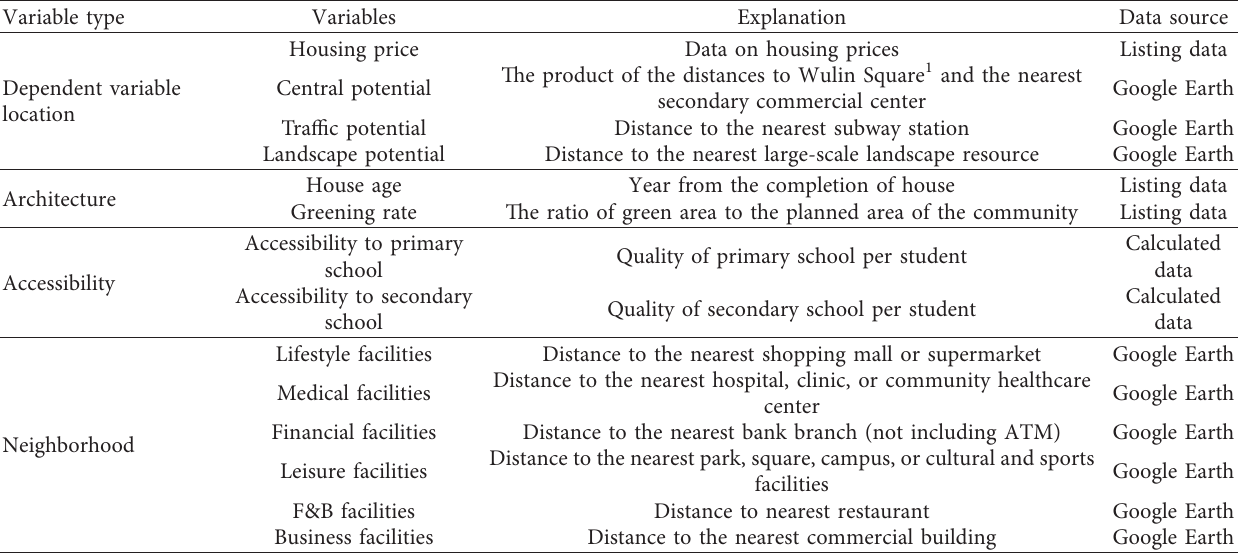
Table 1: Socioeconomic indicators.